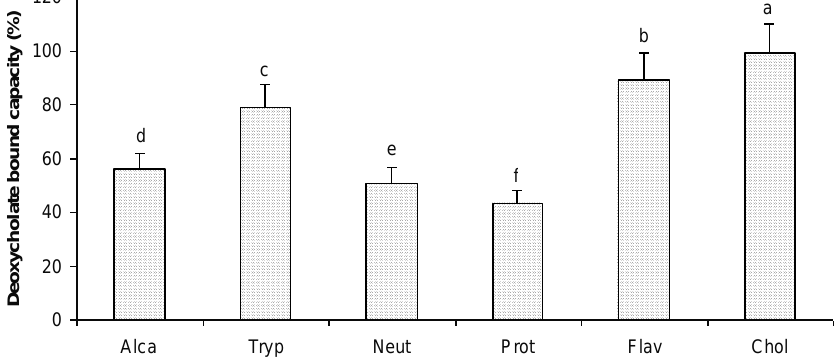
Figure 4. Sodium deoxycholate binding by peptides from five differents hydrolysates of defatted corn protein. Alca: Alcalase; Tryp: Trypsin; Neut: Neutrase; Prot: Protamex; Flav: Flavourzyme. Cholestyramine (Chol) was used as a positive control. Different letters indicate significant differences ( p <